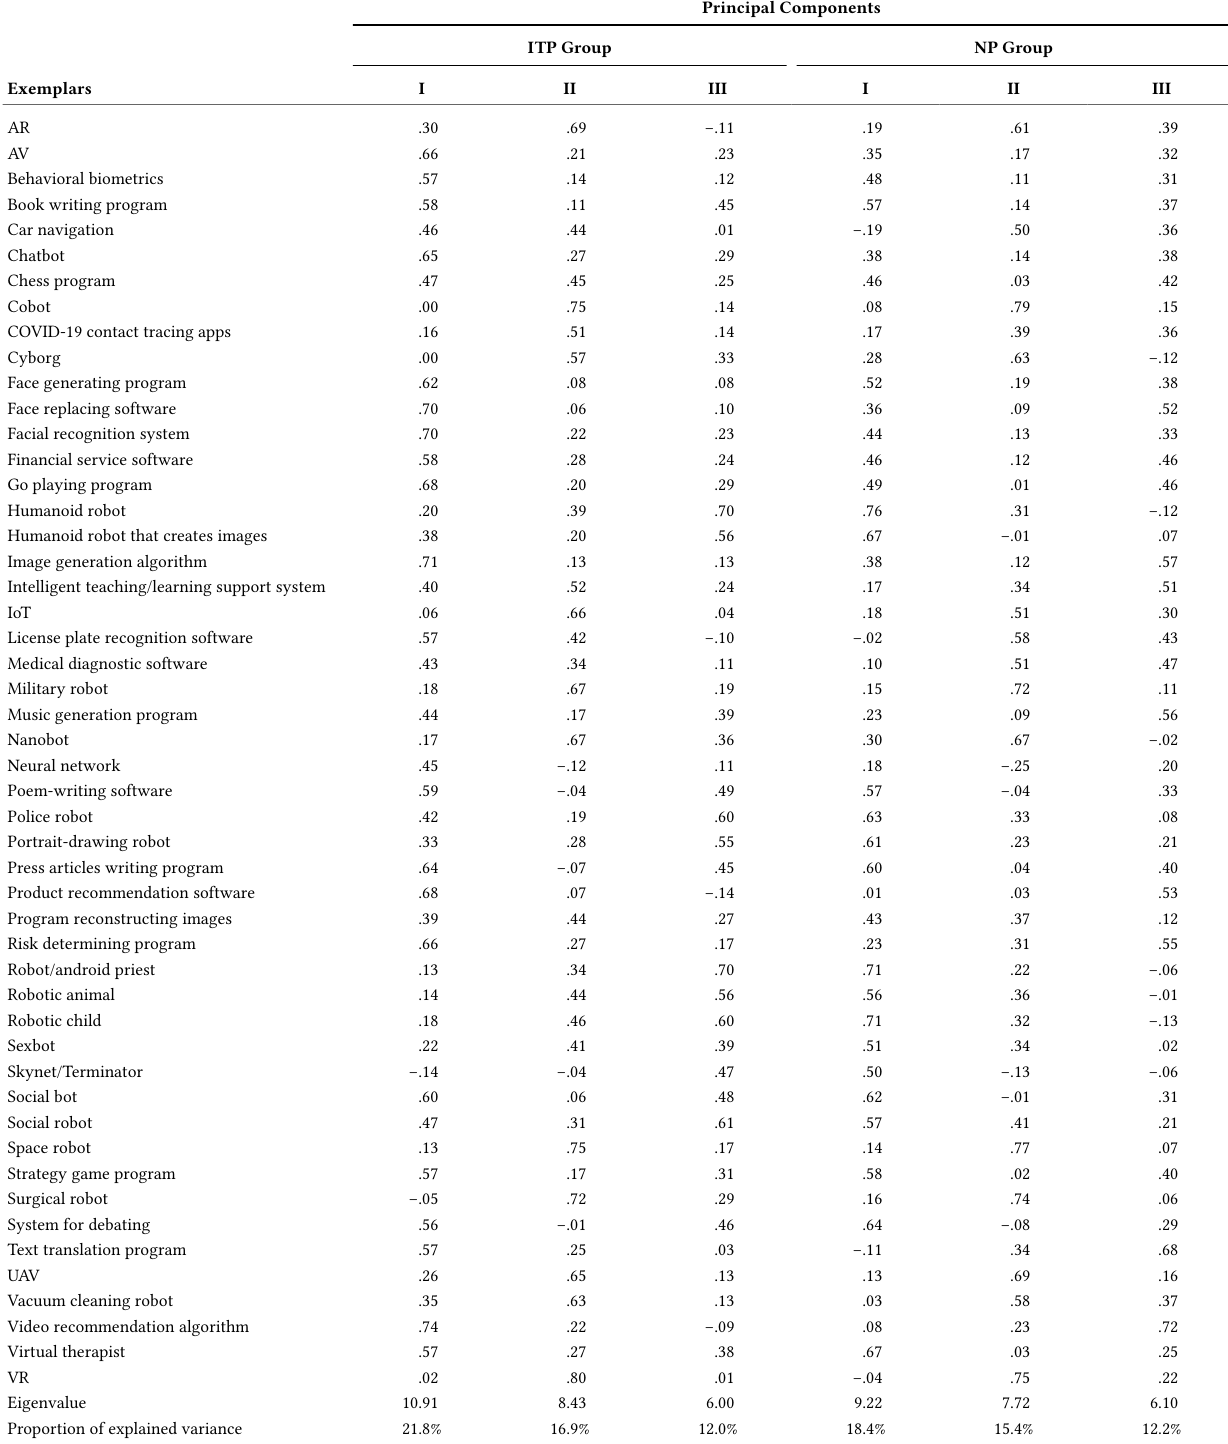
The Structure of Perception of AI Category in ITP and NP Groups: Loadings of Principal